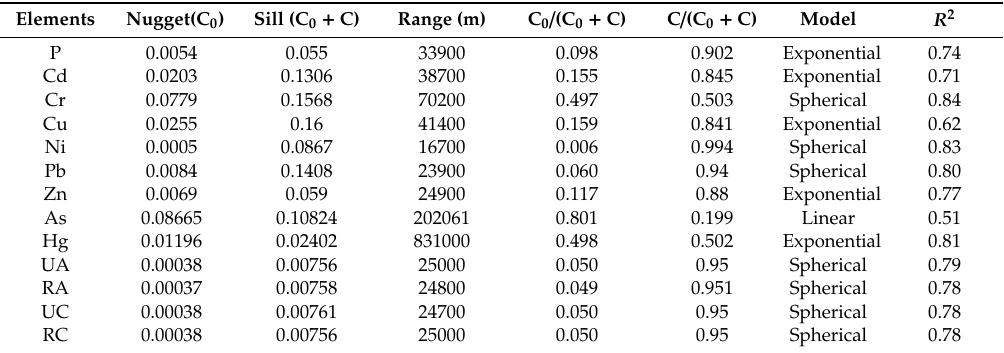
Table 1. The statistically optimal model and parameters of semivariogram function of trace metal(loid)s, pollution index, and health risk